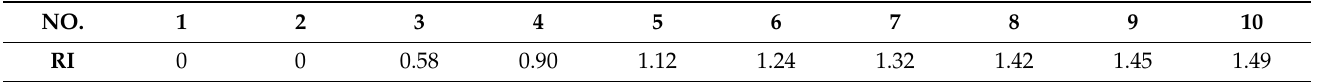
Table 2. The random consistency index value for AHP